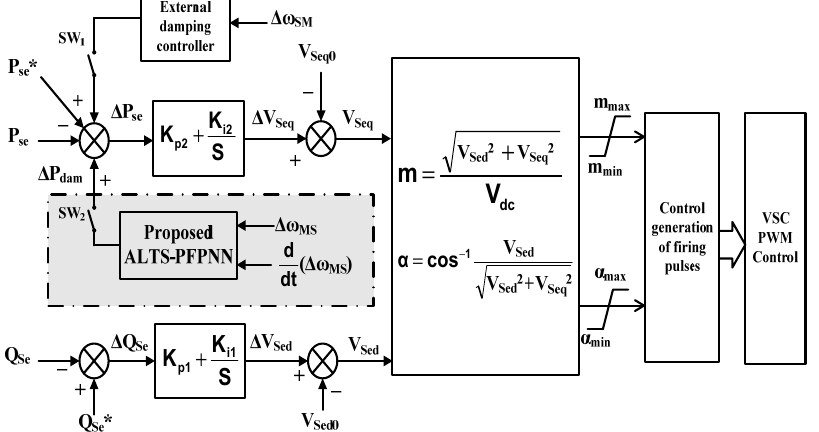
Figure 4. Block Diagram of PID Controller.